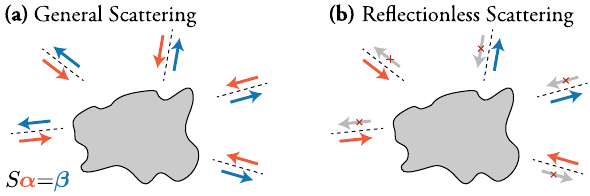
Figure 1: Schematic depicting a (a) general scattering process and (b) re fl ectionless process. A fi nite scatterer/cavity interacts with a fi nite set of asymptotic incoming and outgoing channels, indicated by the red and blue arrows, respectively, related by time